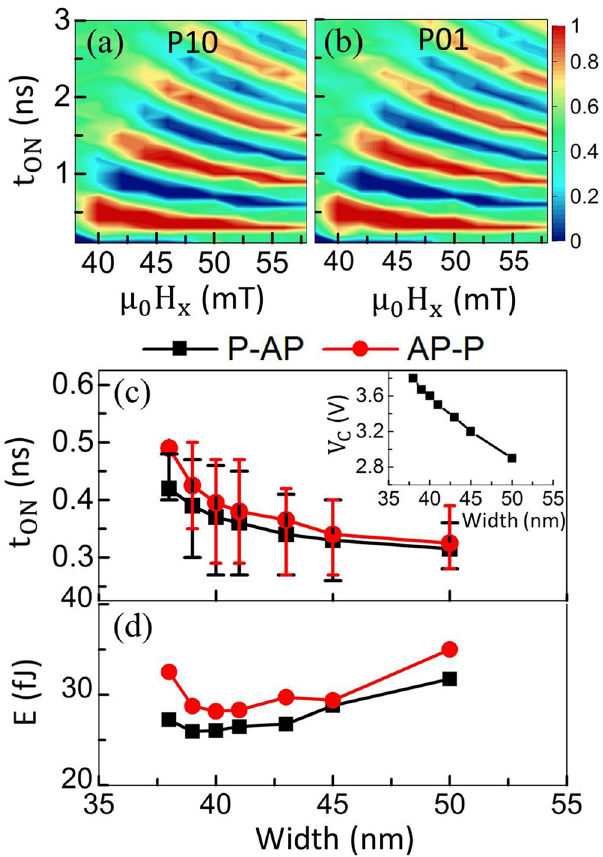
Figure 5. Phase diagram for switching probability of ( a ) P-to-AP and ( b ) AP-to-P as a function of t ON and bias magnetic field μ 0 H x . H x is the magnitude of H Bias projecting along x-axis. Optimal t ON used to switch (t Half ) in ( c ) and energy consumption in ( d ) as a function of the MTJ width. The AR and FL thickness are held constant at 3 and 1.7 nm respectively, e.g. for width of 40 nm, the MTJ cross-section is 40 × 120 nm 2 .The black and red bars indicate the t ON operation regions during which switching probability is 100%. The inset shows the critical voltage V C vs . the MTJ